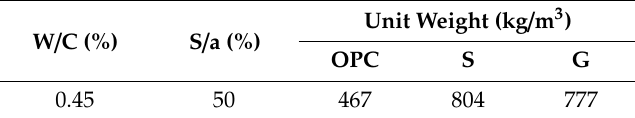
Table 3. Mixture proportion of plain